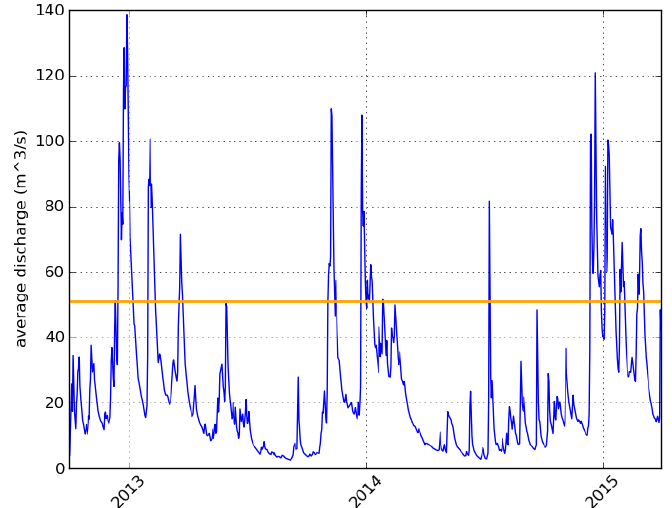
Figure 3. Observed average daily discharge of the Ourthe at Tabreux (blue line), and P90 threshold (orange line). The P90 threshold is the discharge that is exceeded 10% of the time during the verification